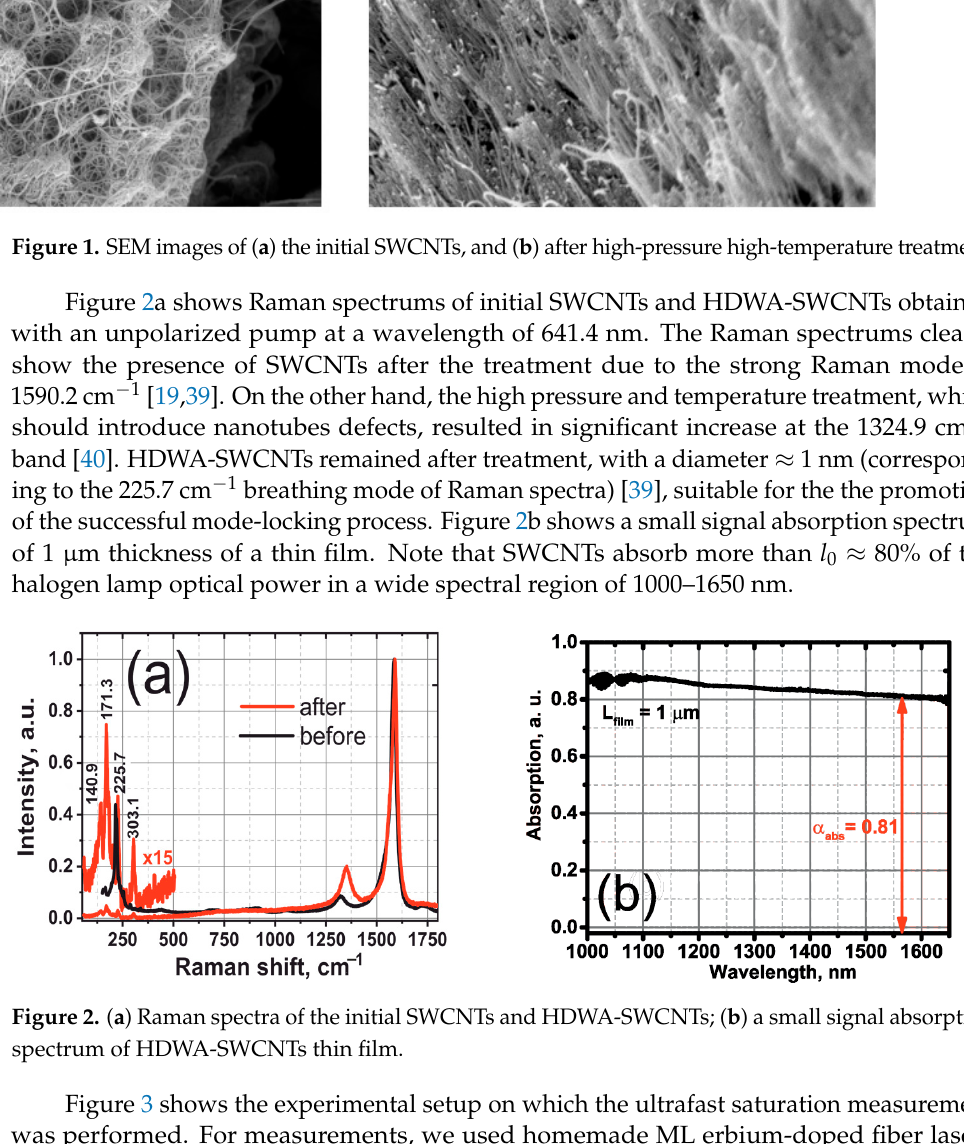
Figure 2. ( a ) Raman spectra of the initial SWCNTs and HDWA-SWCNTs; ( b ) a small signal absorption spectrum of HDWA-SWCNTs thin film.